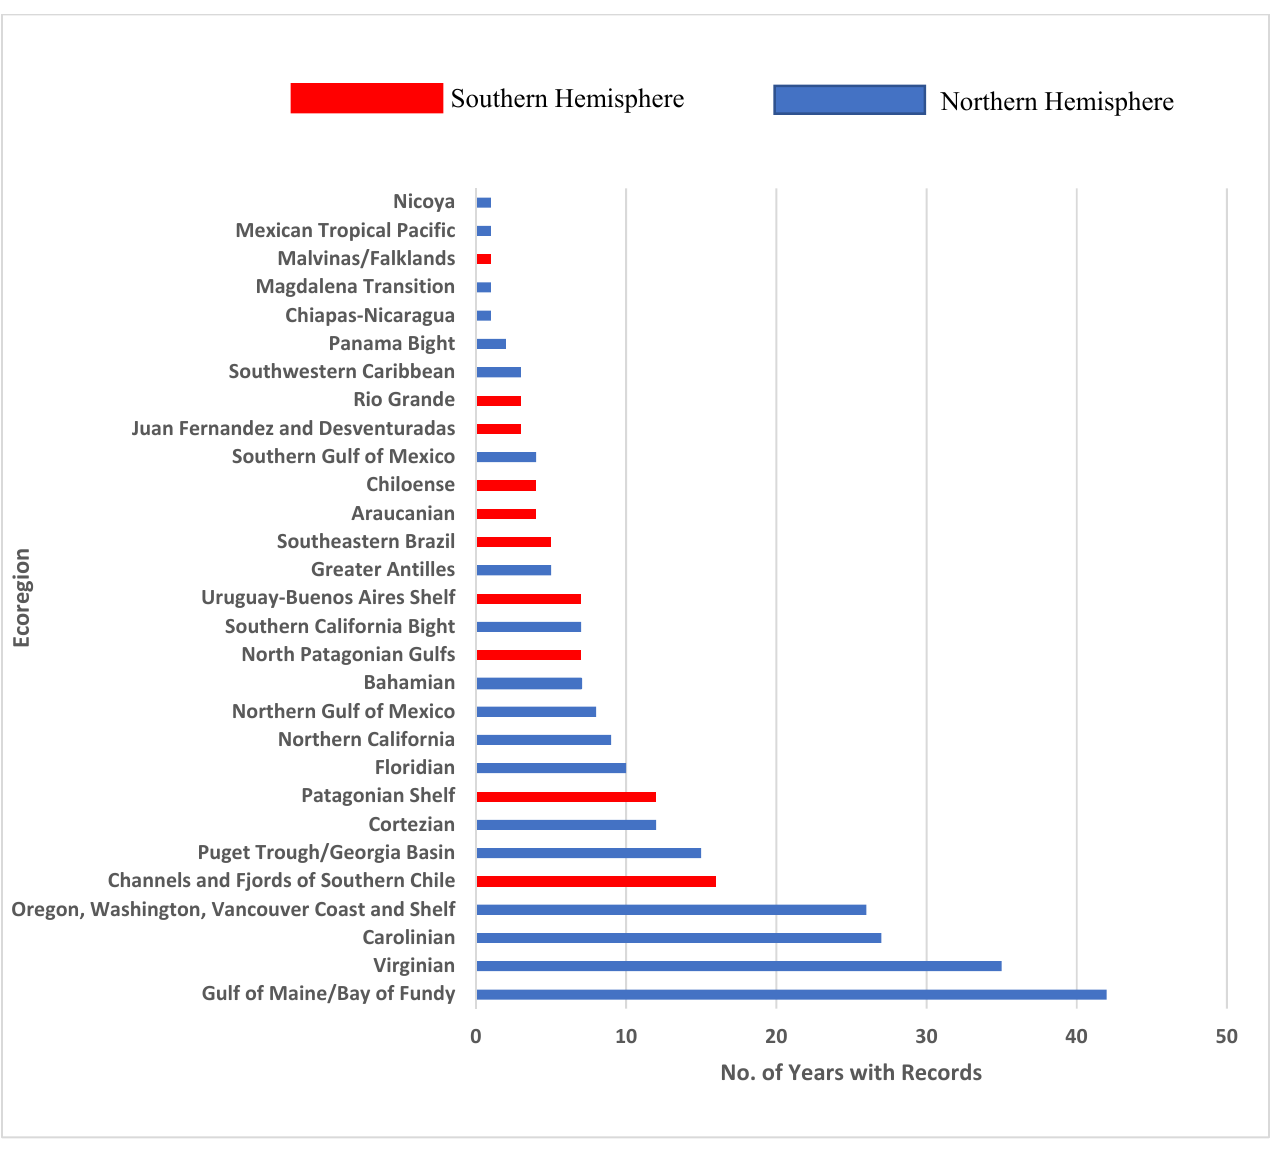
Figure 3. Marine ecoregions of the Americas [14] and the number of years from 1960–2018 for which the OBIS database [7] contained sea- and shorebird data.